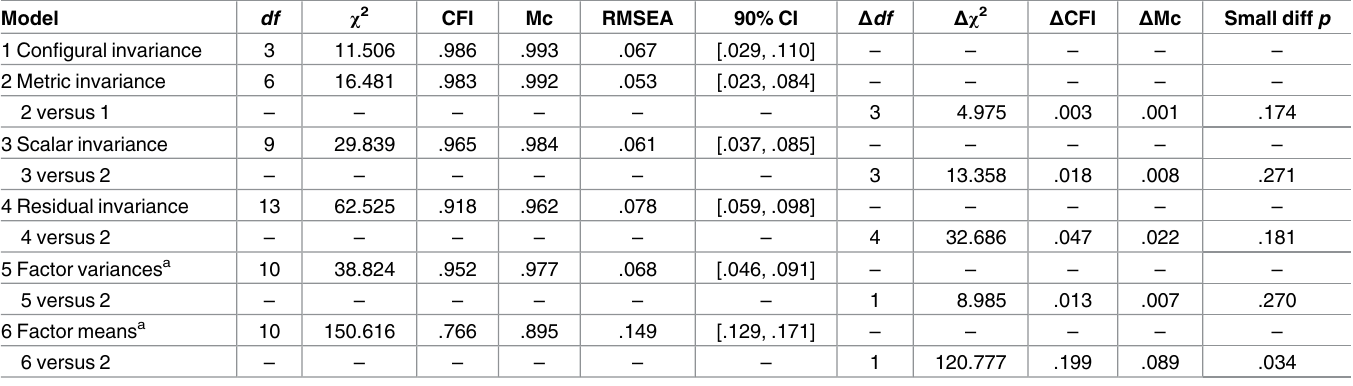
Table 4. Fit Indices for Multi-group Confirmatory Factor Analysis Evaluating Measurement Invariance of the Single-factor Structure Including the Four Intelligence Subtests Across Individuals With and Without a Migration Background.